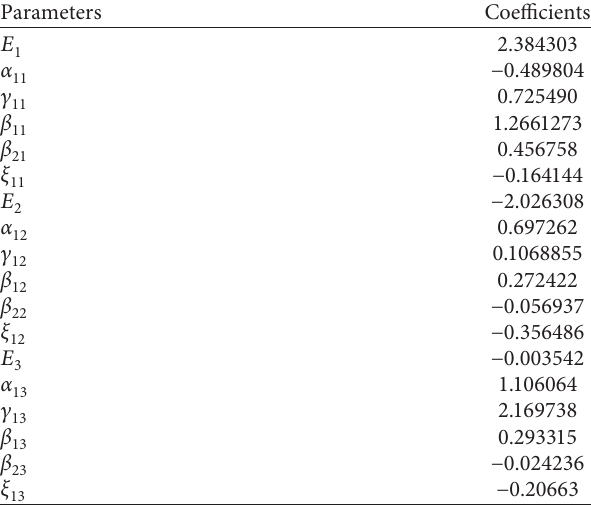
Figure 8: The realized volatility from the simulated residual series. Table 5: The estimated parameters of the fuzzy-EGARCH-ANN model on the first 1000 simulated data points.